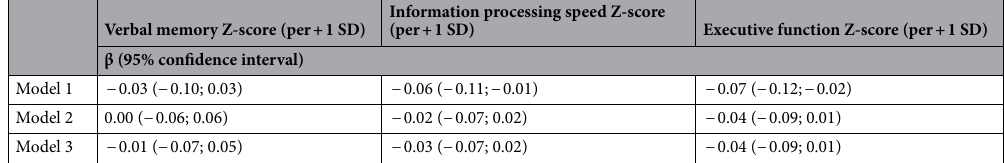
Table 4. Associations serum N-acetylaspartate levels (per higher standard deviation) and domain-specific cognitive performance. Model 1: unadjusted; Model 2: adjusted for age, sex, education and glucose metabolism status; Model 3: additionally adjusted for prior cardiovascular disease, hypertension, smoking and body mass index. *Data available in n =